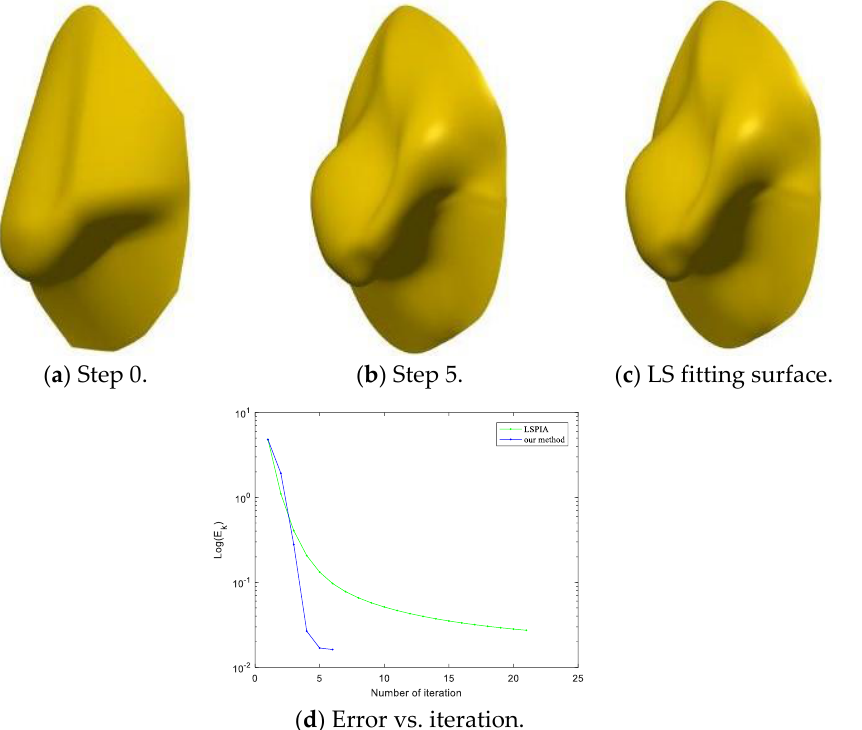
Figure 3. A data point grid with 21 × 21 points was fitted by a bi − cubic tensor product B − spline surface with 10 × 10 control points.